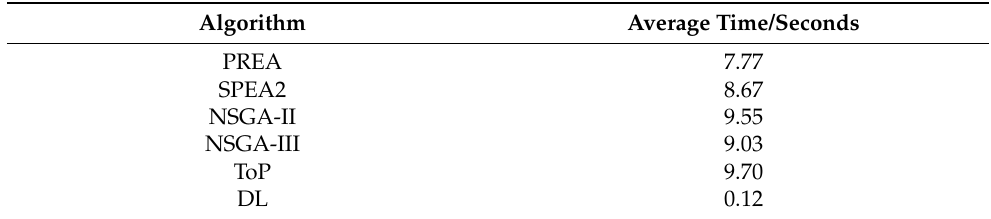
Figure 6. Examples of DL prediction and raw data in IEEE-33 bus system. ( a ) Example 1; ( b ) Example 2. Table 5. Comparison of time required for different algorithm optimization and DL prediction in IEEE-33 bus system.